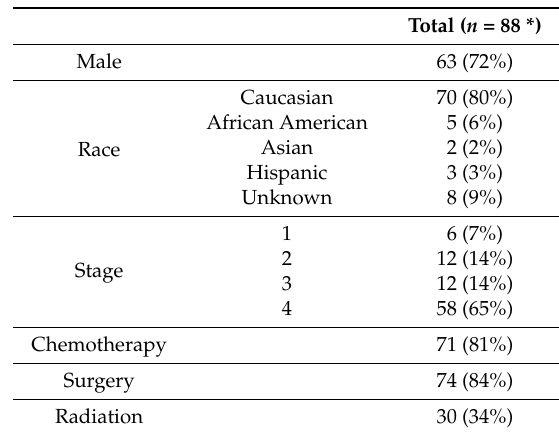
Table 1. Characteristics by cancer